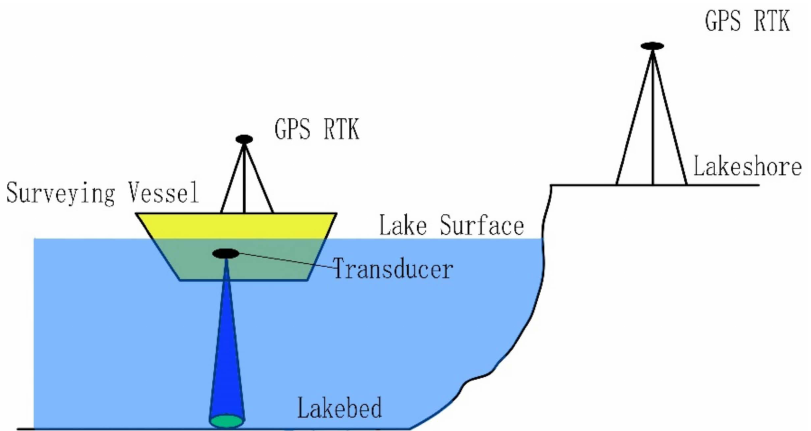
Figure 3. Schematic diagram of the working principle of the single-beam echo